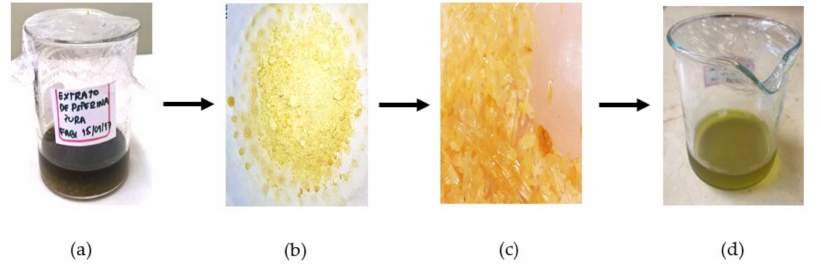
Figure 11. ( a ) Supernatant solution with the piperine crystals; ( b ) solid obtained via vacuum filtration; ( c ) purified piperine crystals, and ( d ) remaining solution